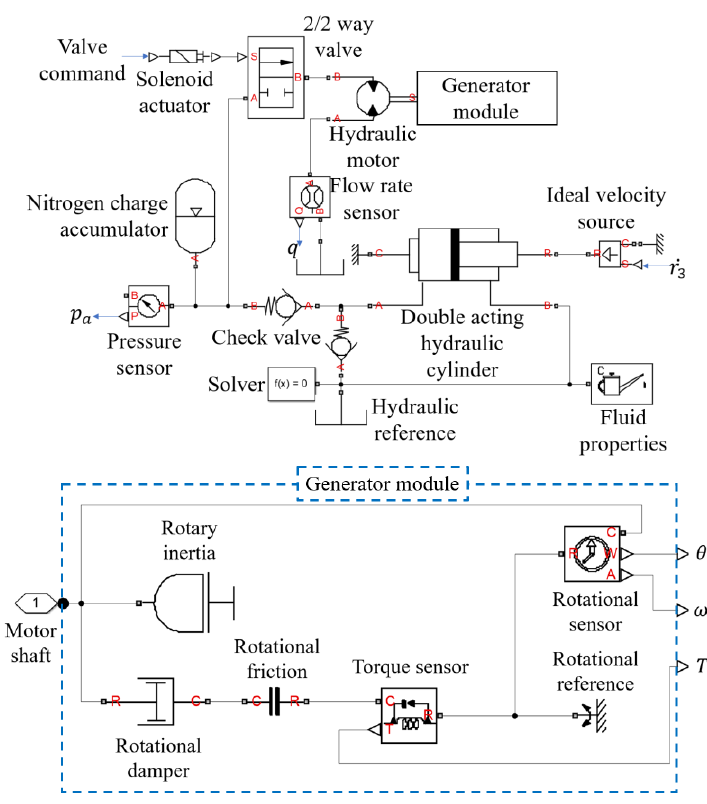
Figure 4. Simulink block diagram for dynamic simulation of the electrohydraulic circuit. Note the electrical generator is emulated by a user-defined “generator module,” which contains a rotary inertia, a rotational damper, and friction. The motor shaft motion works as the input. The resultant angular velocity and the torque are the outputs.